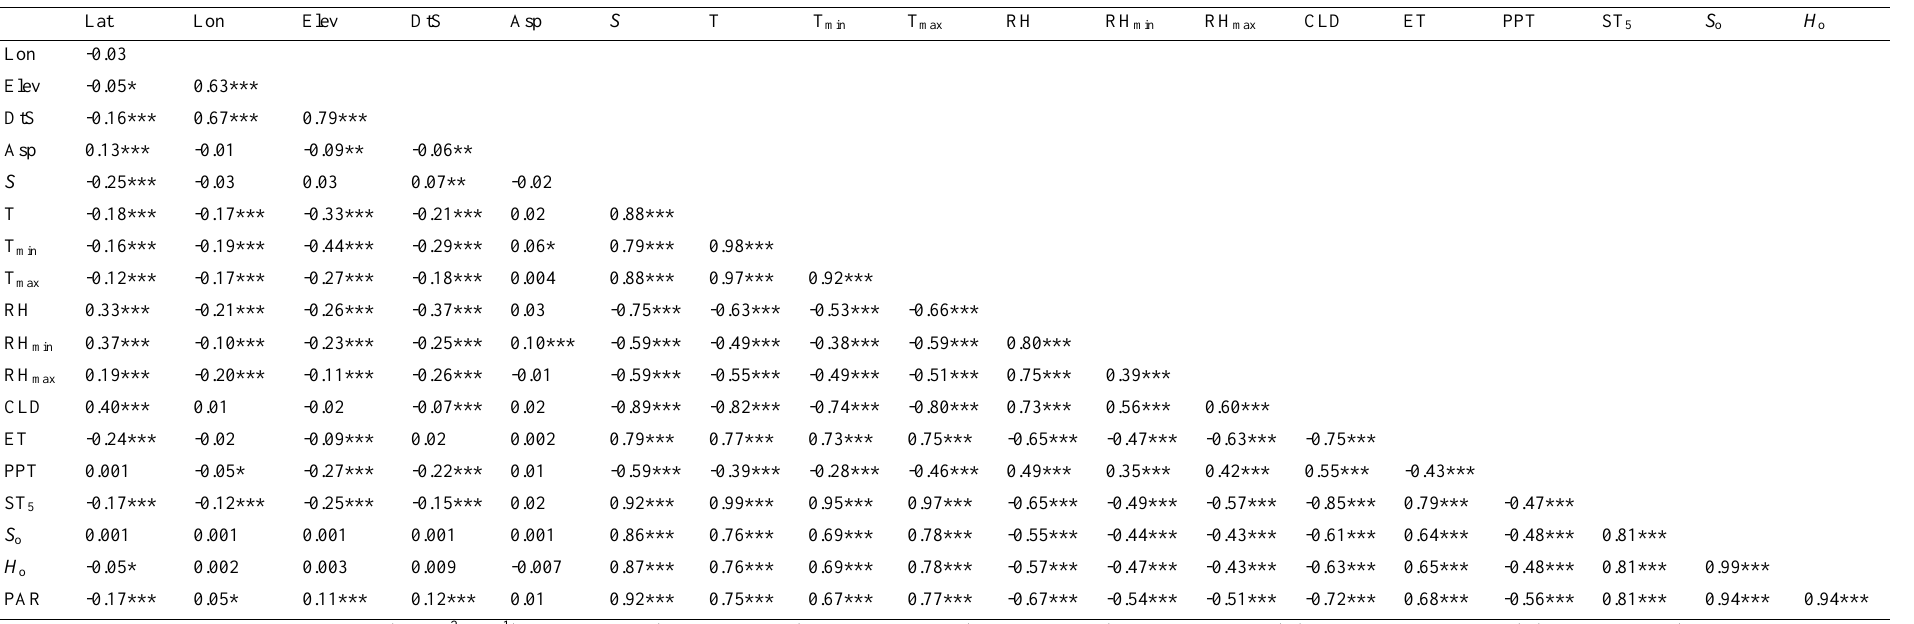
Table 2. Pearson’s correlation matrix of 19 variables observed at 160 climate stations in